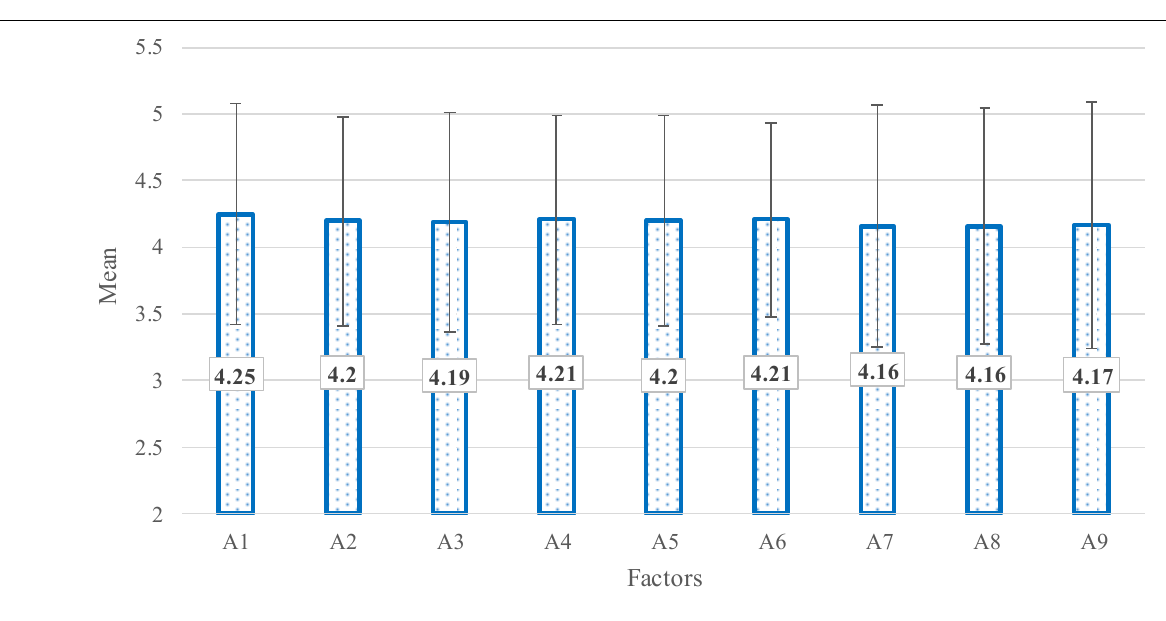
FIGURE 5 | Means of each factor in Adaptability scale ( N =